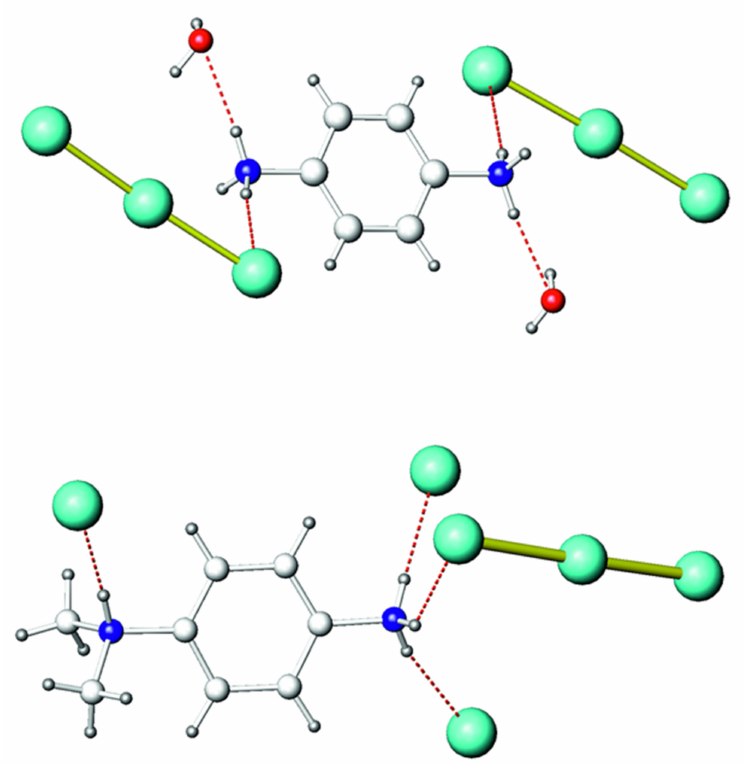
Figure 2. Local coordination of diammonium cations in the crystal structures of 1 ( top ) and 2 ( bottom ). Iodine, green; oxygen, red; nitrogen, blue; carbon, light gray; hydrogen, dark gray. Hydrogen (N)H ··· O and (N)H ··· I bonds are shown as red dashed lines. The (N)H ··· I bonds caused an asymmetry of the I 3 - anions. Indeed, in both